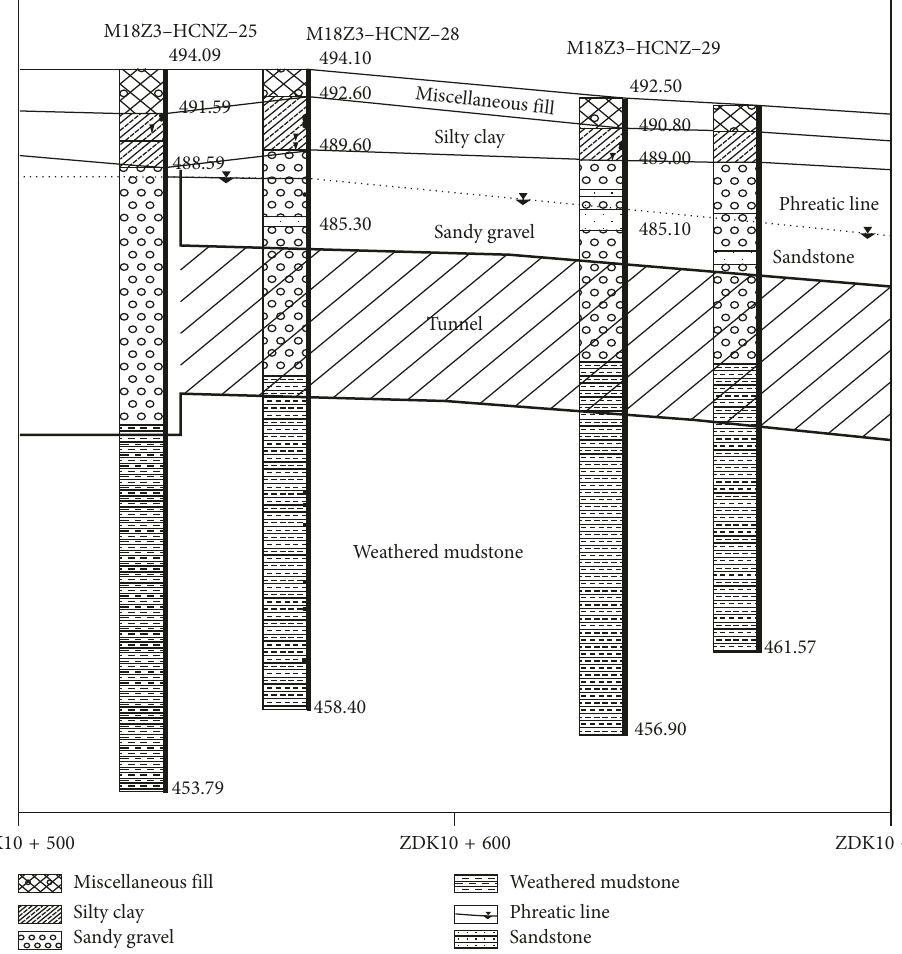
Figure 1: Brief geological profile of tunnel entrance. The profile contains soil type and tunnel excavation situation; M18Z3-HCNZ-25 to 29 represent four